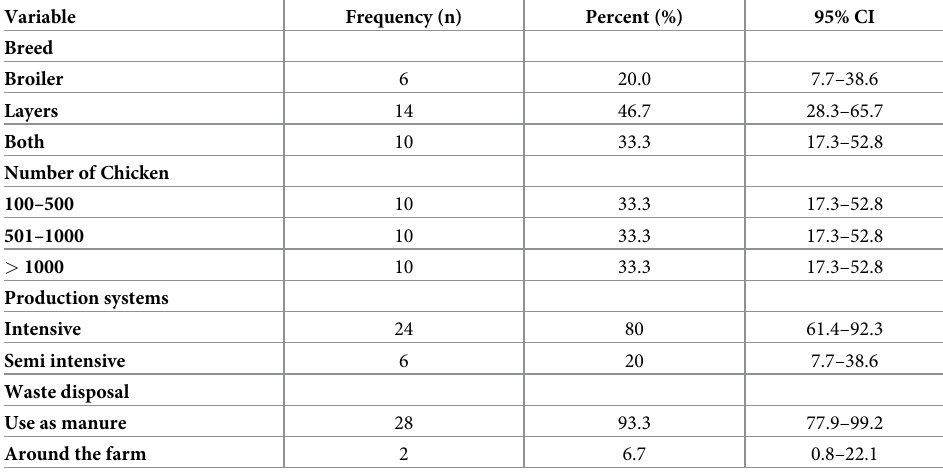
Table 5. Farming characteristics of chicken production (n = 30).